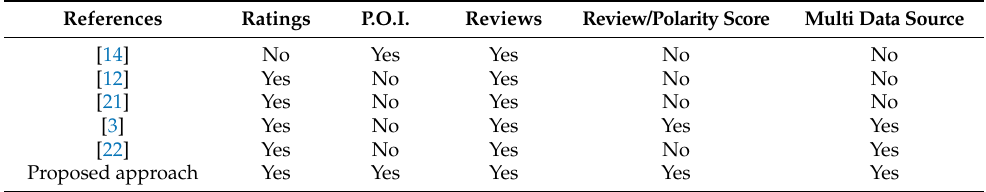
Table 2. Deviation of various approaches.